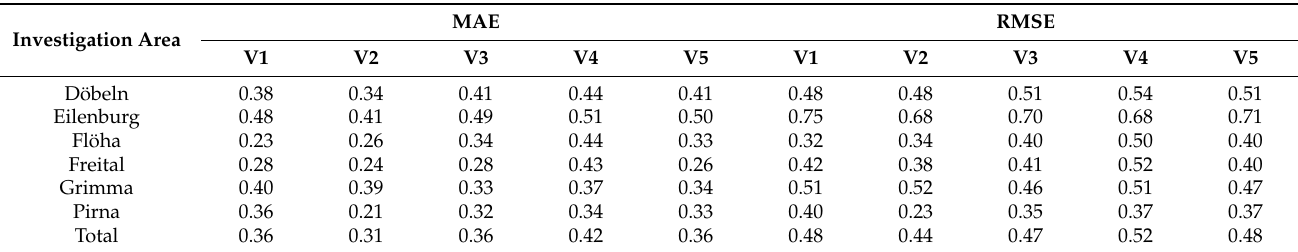
Table 7. Error analysis for Level I (excluding flow velocity).